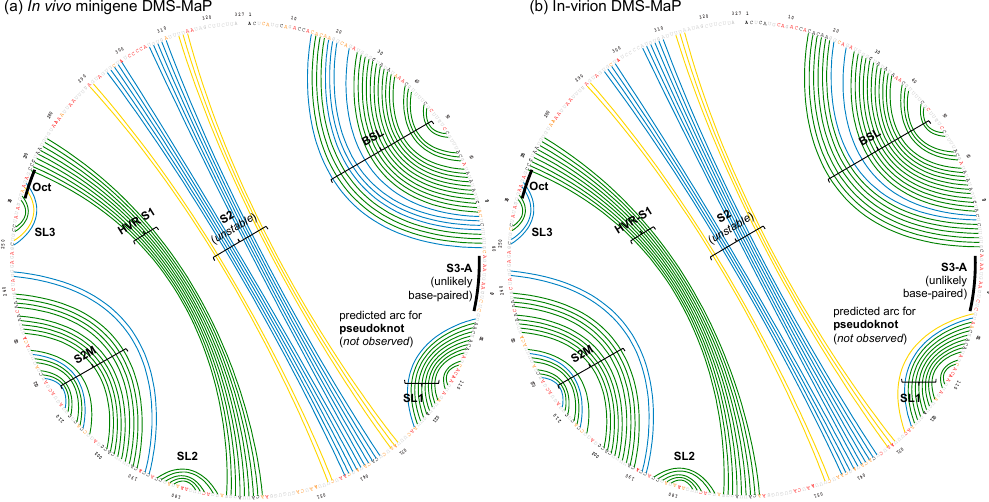
Figure 3. Arc plots of the most possible base-pairing pattern for SARS-CoV-2 3 ′ UTR. A colored arc represents a base pair with the following probability: 100% > green ≥ 80% > blue ≥ 30% > yellow ≥ 10%. By definition, ∆ nDMS is high when ∆ nDMS > 0.85, medium 0.40 < ∆ nDMS ≤ 0.85, or low ∆ nDMS ≤ 0.40, and the corresponding nucleotide symbol is colored red, orange, or black, respectively. The nucleotides of G and U, or within PCR primer-binding regions, where the DMS data is not available, are colored grey. The arc plots were generated by the SuperFold software package [26] from the experiments ( a ) in vivo minigene DMS-MaPseq, and ( b ) in-virion DMS-MaPseq. See Figure S2 for full arc plots with all possible base-pairing possibilities. 3.2. DREEM Analysis Uncovered an Unexpected Lack of the Pseudoknot and Three-Helix Junction in the 3 ′ UTR In both the in vivo minigene and in-virion DMS-MaPseq, the pseudoknot with base pairs of L1– BS-B was not predicted as a possible conformer (Figures 3 and 4 and Figure S2), although they are complementary Watson-Crick pairs. The base pairing of BS-A–BS-B and BS-B–L1 cannot simultaneously occur. Therefore, the extended BSL (E-BSL) with BS-A–BS-B and a pseudoknot with BS-B–L1 are mutually exclusive, which is the basis of the molecular switch hypothesis [6]. In theory, in case the pseudoknot forms, the DMS activities for L1 and BS-B should both be low in an RNA helix, leaving the high DMS reactivities on the unpaired BS-A segment. On the contrary, in-virion DMS- MaPseq clearly showed low DMS activities on BS-A (Figure 3), thereby exclude the possibility of the pseudoknot to form as a major conformer. The in vivo minigene DMS-MaPseq, on the other hand, showed medium-to-high DMS activities on both segments BS-A and L1 (Figures 3 and 4). This finding led us to ask: is it possible that the 3 ′ UTR is in an equilibrium between a more favorable E-BSL and a less favorable pseudoknotted conformation in the minigene-transfected cells, and the data for the predominant E-BSL masks the prediction of a pseudoknot using the conventional DMS-MaPseq analysis? To answer this question, we applied a recently developed algorithm, DREEM, to isolate less populated but stable RNA conformers [29]. Compared to other programs that can uncover different structural groups in a mixture of RNA conformations [33,34], DREEM is advantageous because it clusters the structural groups in the first step and analyzes the RNA structure within the individual groups [29]. The DREEM algorithm groups multiple DMS-modified sequencing reads that cover 95%